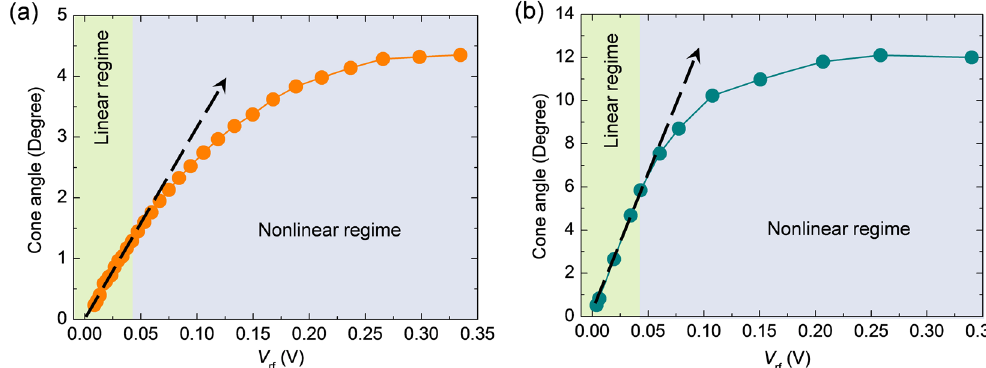
Figure 4. Cone angle of magnetization precession, evaluated from ( a ) experimental results and ( b ) micromagnetic simulations, are plotted as a function of applied rf voltage. Arrows with solid dotted lines represent the expected linear variation of cone angle as a function of V rf in the linear regime. The linear and nonlinear regime of magnetization dynamics are demonstrated by two different background colour